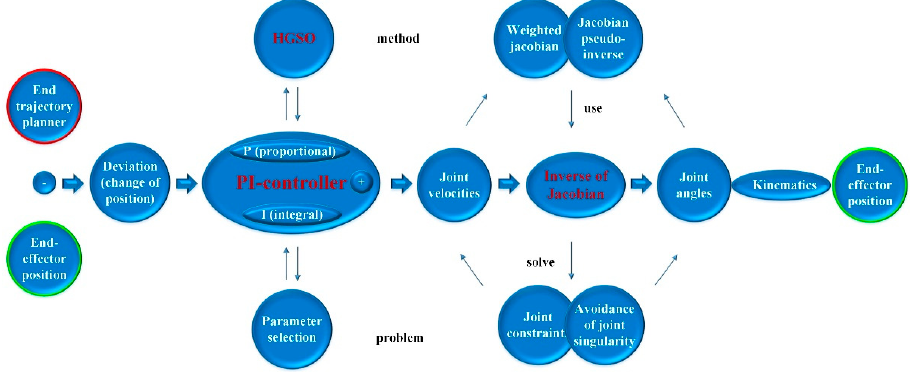
Figure 3. The specific scheme structure diagram of PI-HGSO.